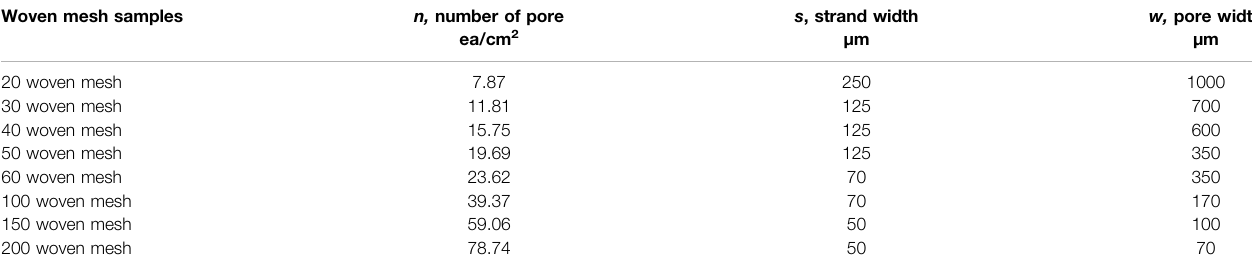
TABLE 1 | Structural parameter of Ni woven mesh samples. Woven mesh samples